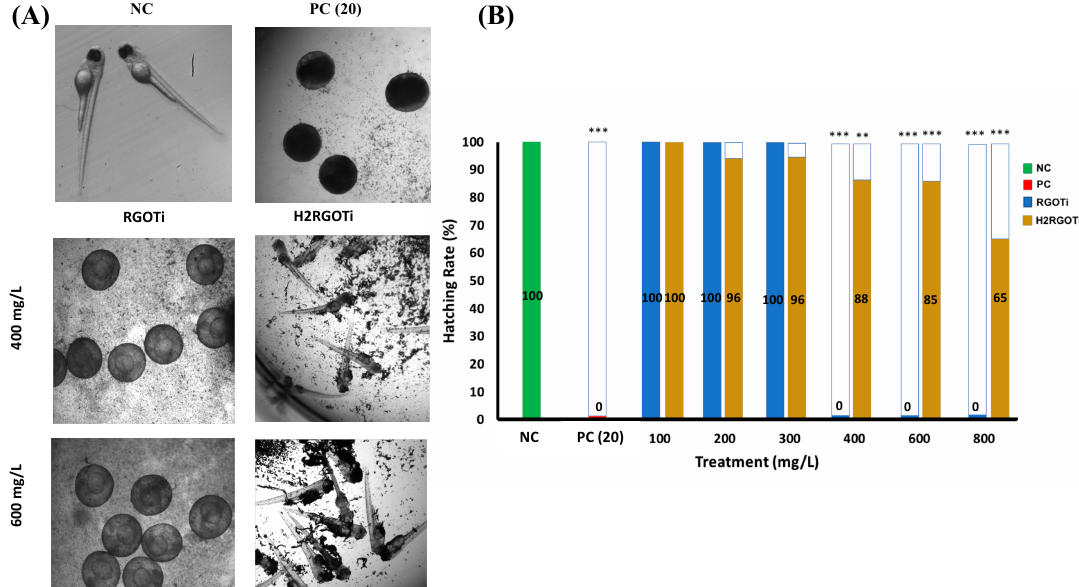
Figure 6. The e ff ect of photocatalytic compounds on the zebrafish embryos hatching rate. ( A ) Representative pictures for the hatching rate at 96-hpf. 400 and 600 mg / L of RGOTi showed complete inhibition of the zebrafish embryos hatching rate by 96-hpf. However, embryos treated with H 2 RGOTi eventually hatch by 96-hpf. ( B ) Embryos treated with H 2 RGOTi showed a dose-dependent decrease in the hatching rate. The Chi-square test was used to calculate the significance between the percentages compared to NC, n = 50. (*) = p < 0.05; (**) = p < 0.01; (***) = p < 0.001.